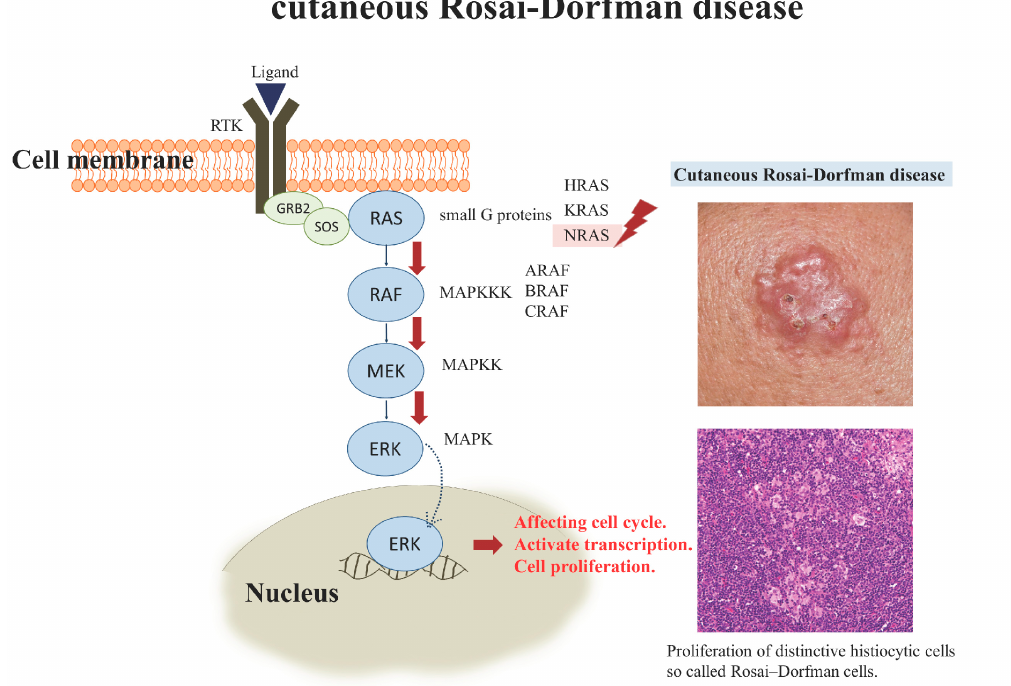
Figure 3. Our hypothetical thesis of molecular pathogenesis of cutaneous RDD. In MAPK/ERK pathway, a signaling cascade is initiated when ligands bind to two receptor tyrosine kinases (RTK) subunits and induce receptor dimerization. Adaptor proteins such as growth factor receptor binding protein 2 (GRB2) result in the recruitment of guanine nucleotide exchange factors (GEFs) such as Son of Sevenless (SOS) protein to the cell membrane. SOS then activates RAS by facilitating the small G proteins, including RAS subfamily GTPases such as HRAS, KRAS, and NRAS, to dissociate from GDP and bind to GTP. GPT-bound RAS then activates RAF, a subfamily of MAPKKK, which phosphorylates MEK (MAPKK). Phosphorylated MEK in turn activates ERK (MAPK). Activated ERK enters the nucleus, where it phosphorylates numerous nuclear transcription factors and modulates gene expression, which regulates many cellular processes, including cell proliferation, survival, differentiation, apoptosis, motility, and metabolism. When NRAS gene gets mutated, the signal pathway will lose its normal regulation, which activates the downstream cascade resulting in the proliferation of distinctive histiocytic cells in cutaneous